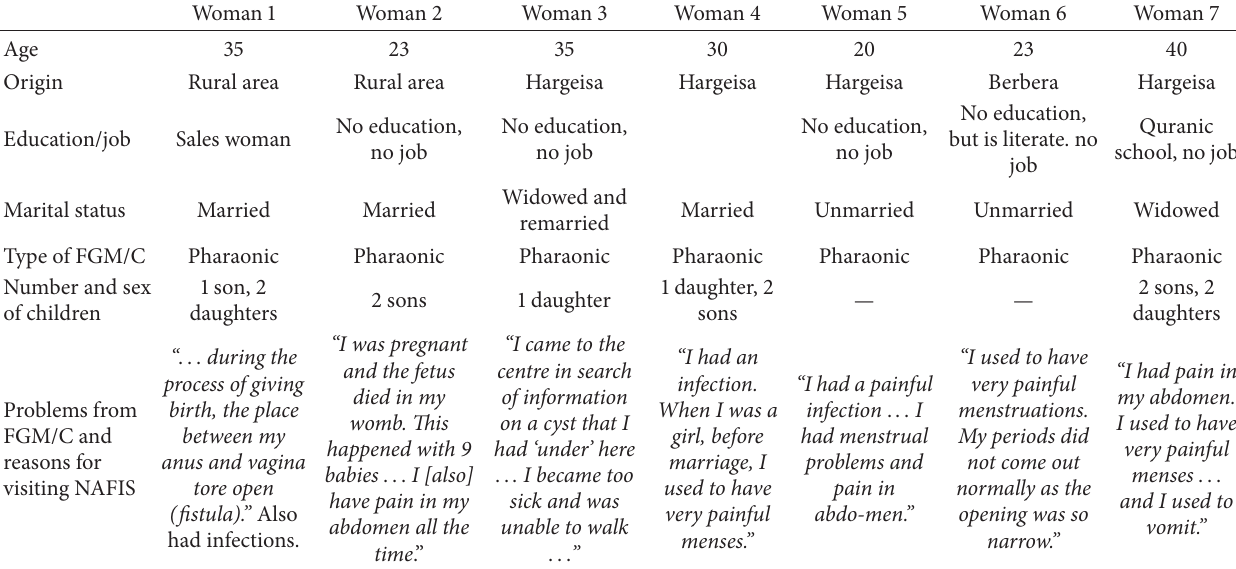
Table 2: Background characteristics of participants.